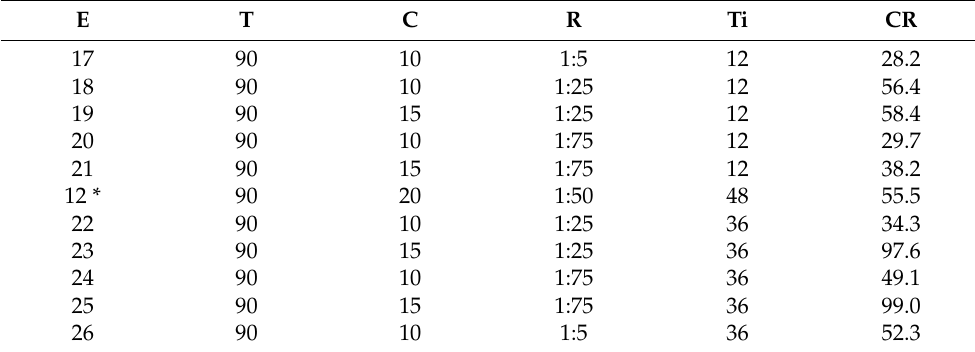
Table 10. Reaction parameters in the boundaries of Experiment 12 (Table 7).